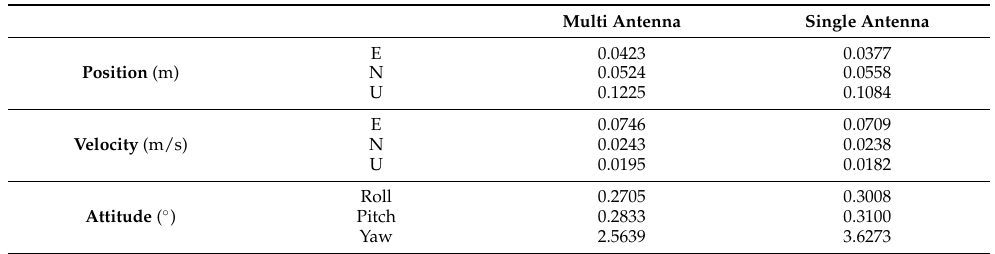
Table 1. Comparison of position, velocity, and attitude accuracy between single-antenna model and multi-antenna